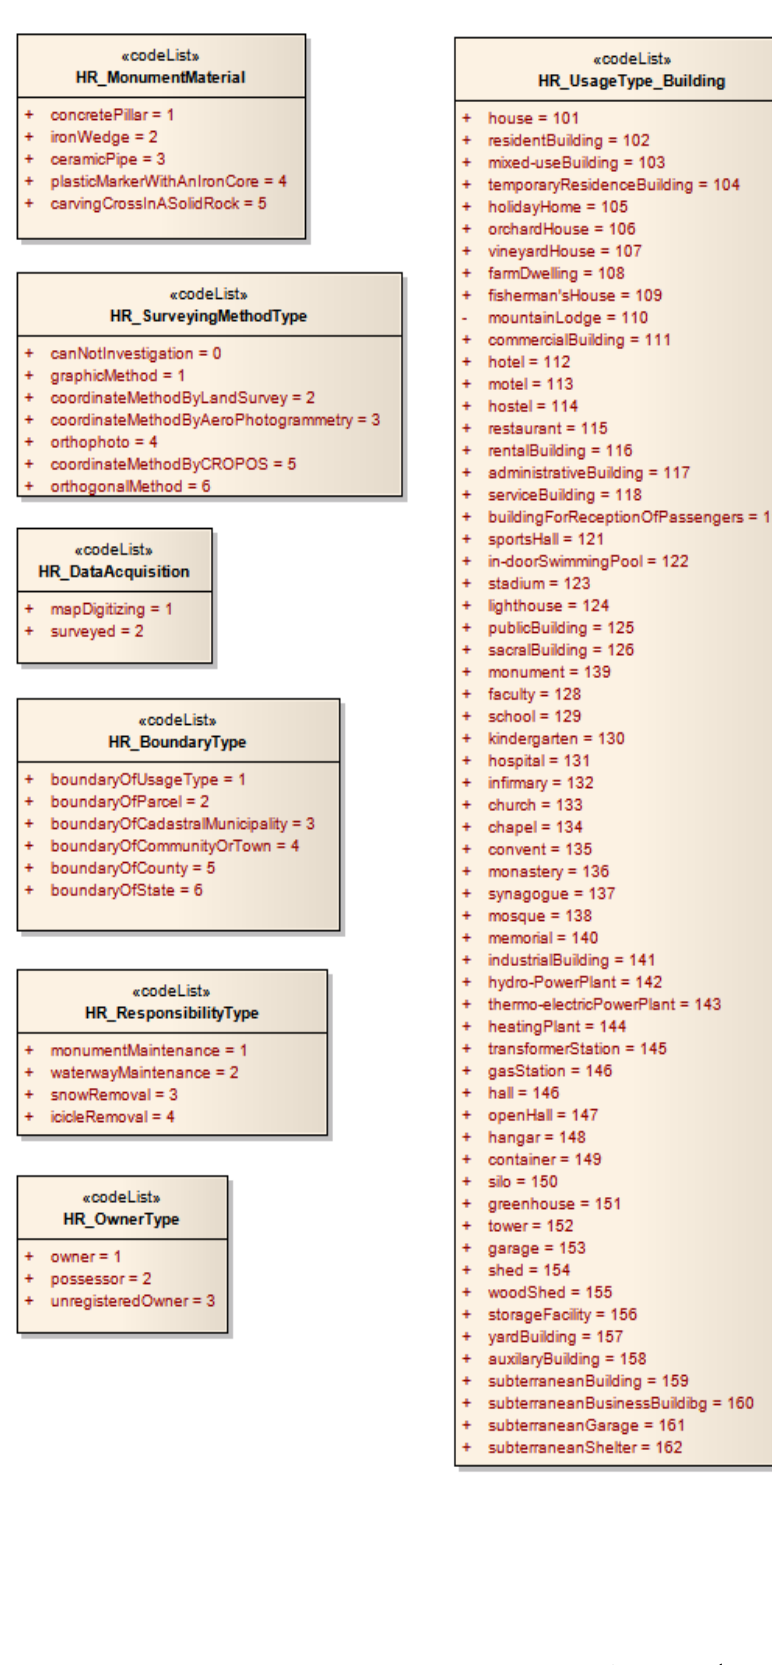
Figure 10. LADM profile Croatia (code